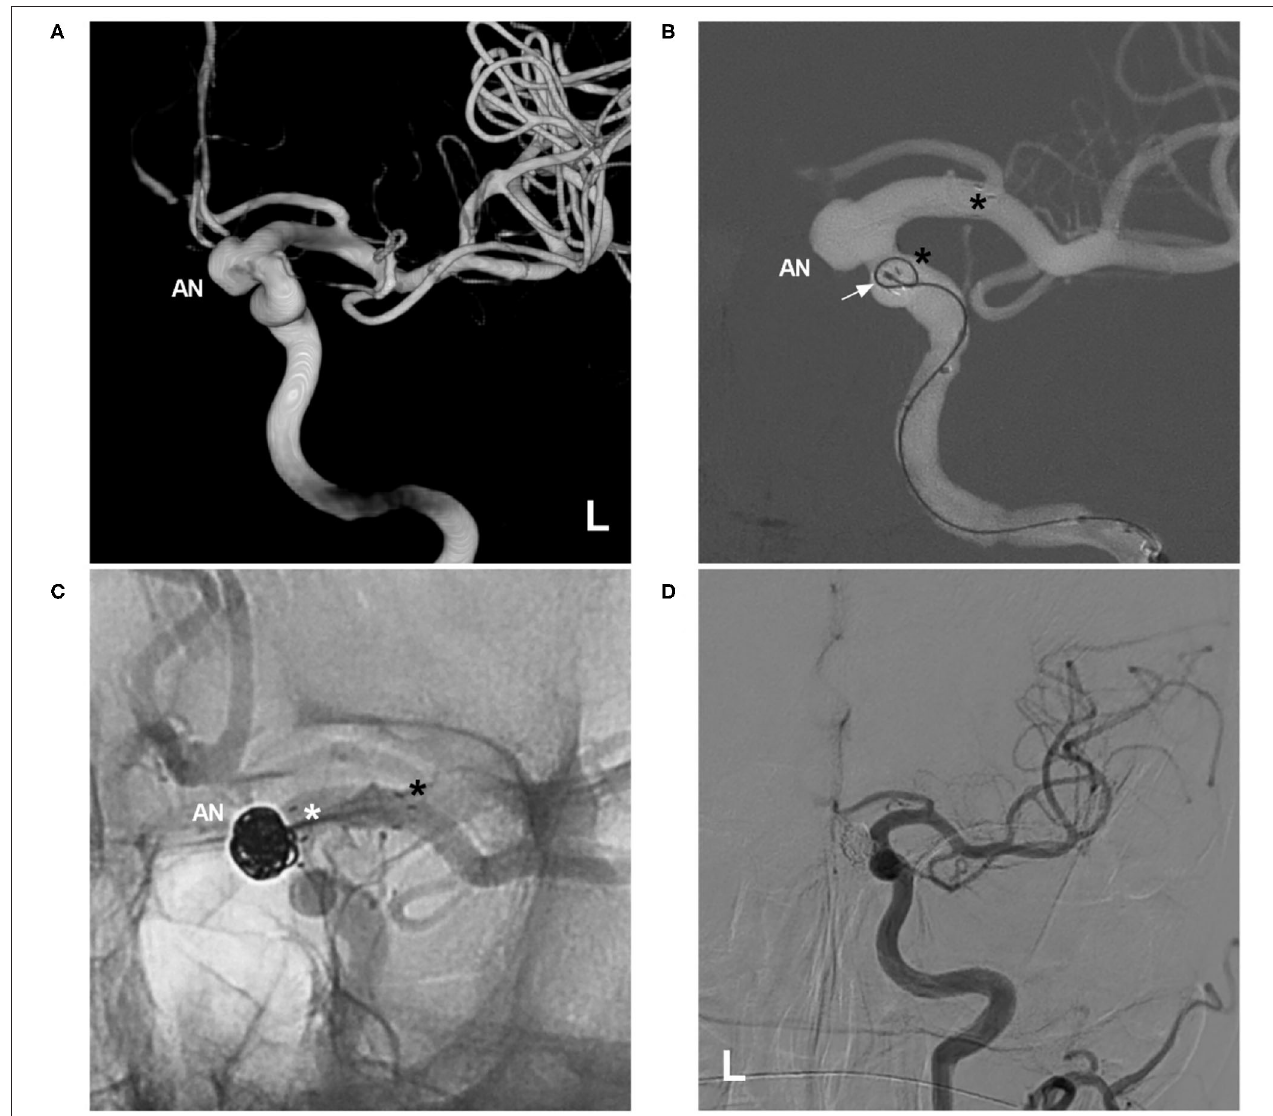
FIGURE 4 | Migration of the proximal NAS segment during the transcell procedure. (A) Three-dimensional DSA of the left ICA showing an ophthalmic artery aneurysm (AN). (B) Map showing deployment of the NAS first; the asterisks indicate the proximal and distal tips, and the arrow indicates the microcatheter during an attempt to cross the NAS. (C) Unsubtracted DSA showing that the proximal segment of the NAS (white asterisk) was pushed distally by the microcatheter tip, part of the aneurysm neck was uncovered, the distal segment of the stent (black asterisk) was not moved, and the aneurysm (AN) was still coiled under incomplete protection by the NAS. (D) Follow-up DSA of the left ICA showing complete embolization of the aneurysm. AN, aneurysm; DSA, digital subtraction angiography; ICA, internal carotid artery; NAS, Neuroform Atlas stent; L,